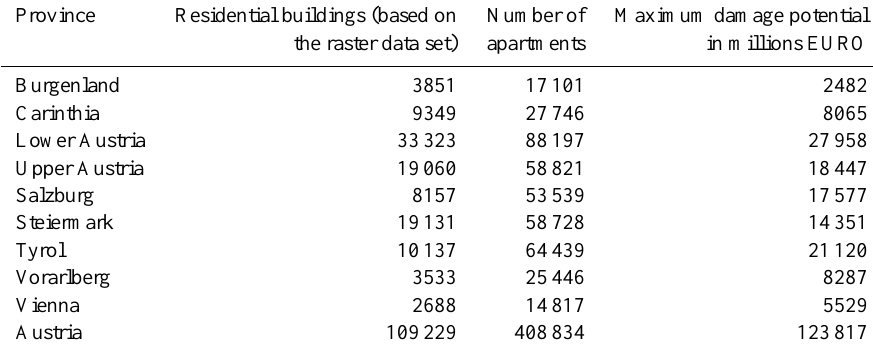
Table 1. Maximum damage potential in the HQ200 risk zones in the provinces of Austria. Province Residential buildings (based on Number of the raster data set)